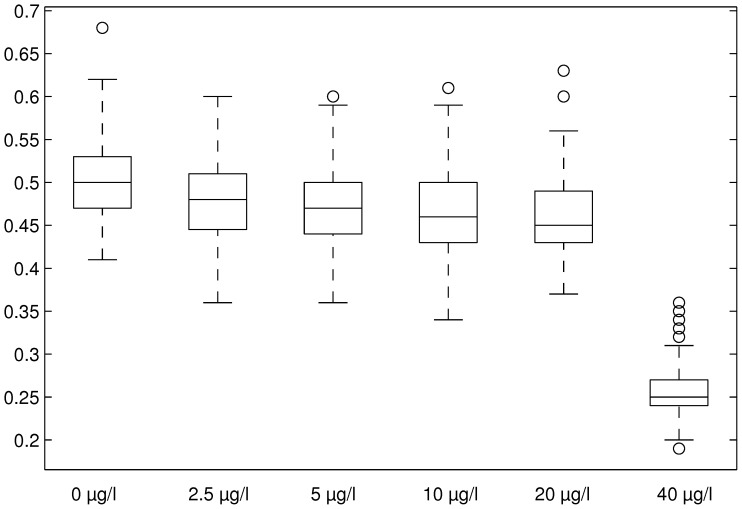
Boxplots for maximum Lyapunov coefficients for DCA treatments for the overall population.Boxes show mean value (horizontal line), 25 and 75% quantile (box edges), 5 and 95% quantile (whiskers) and outliers>2 sd from mean (circles).